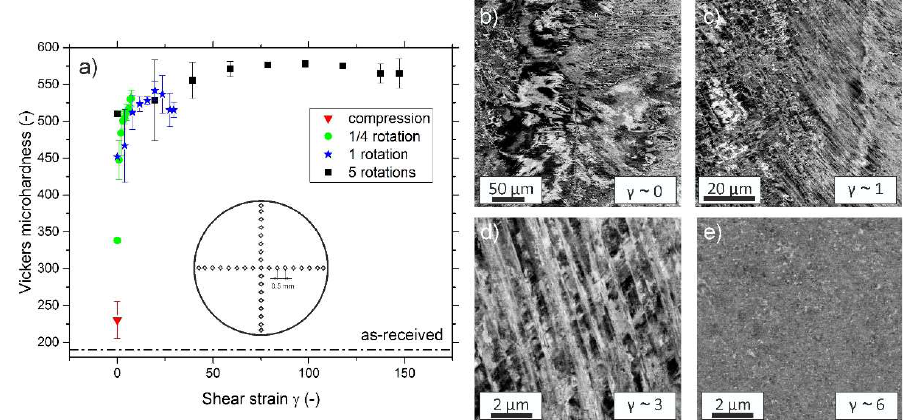
Figure 2. ( a ) Evolution of hardness plotted versus the shear strain applied by high-pressure torsion (HPT). A plateau is reached for shear strains larger than approximately 50. ( b – e ) depict changes in the microstructure during processing. For the low strain region near the center large contrast variations are visible, which suggest the formation of dislocation substructures as well the onset of twinning, ( b ). Even for very low strains mechanical twinning is a dominant deformation mechanism, see ( c ). For slightly higher strains, ( d ), additional twin variants are forming and twins start to intersect each other. ( e ), at γ ~ 6 some regions are already extremely refined, but the microstructure still is not completely homogeneous.